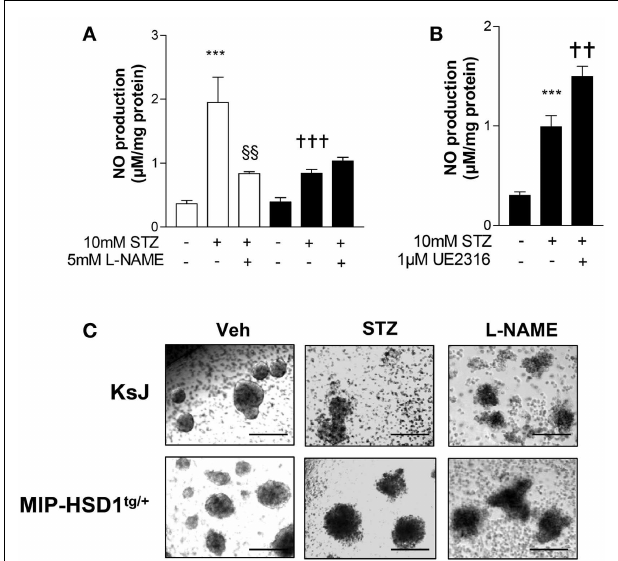
FIGURE 5 | Isolated MIP-HSD1 tg/ + islets show attenuated induction of nitric oxide production and resistance to disintegration in culture after STZ challenge . Islets from 12-week-old mice were isolated and incubated in vitro with vehicle or STZ (10mmol/l) with or without the nitric oxide synthase inhibitor L-NAME (5mmol/l) in the presence of 2nmol/l 11-dehydrocorticosterone 11beta-HSD1 substrate for 72h. (A) Analysis of nitric oxide (NO) production in media after 72h incubation with vehicle ( − ), STZ or STZ + L-NAME from islets from KsJ (white bars) or MIP-HSD1 tg/ + mice (black bars).Values represent mean ± SEM. Differences were analyzed by one-way ANOVA, Newman–Keuls test, *** P < 0.001 for STZ vs.Veh; ††† P < 0.001 for MIP-HSD1 tg/ + STZ vs. KsJ STZ, §§ P < 0.01 STZ + L-NAME vs. STZ ( n = 6). (B) NO production in media of isolated islets from MIP-HSD1 tg/ + mice treated with STZ with or without 11beta-HSD1 inhibitor UE2316 (1 µ mol/l) for 72h.Values represent mean ± SEM, differences analyzed by one-way ANOVA, Newman–Keuls test, *** P < 0.001 for STZ vs.Veh; ** P < 0.01 for STZ + UE2316 vs. STZ ( n = 6). (C) Representative light microscopy images of islets from KsJ (upper row) and MIP-HSD1 tg/ + mice (lower row) incubated with vehicle (left lane), with STZ (middle lane), or with STZ + L-NAME (right lane). Magnification ×